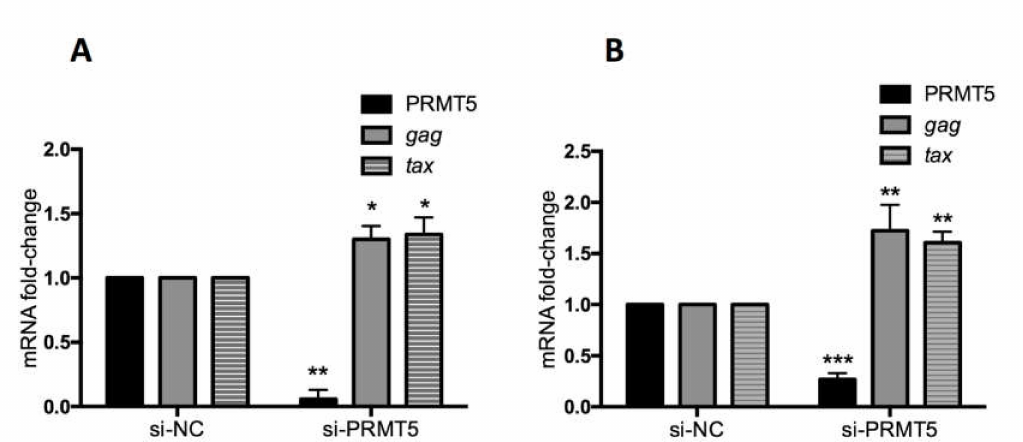
Figure 4. E ff ect of PRMT5 knockdown on BLV gene transcription. FLK-BLV ( A ) or PK15-BLV ( B ) cells were transfected with scramble siRNA (si-NC) or siRNA targeting PRMT5 (si-PRMT5) for 48 h for FLK-BLV or 72 h for PK15-BLV. BLV gene transcription (mRNA- gag and mRNA- tax ) in addition to PRMT5 gene expression at the RNA level was evaluated by qRT-PCR. The ∆∆ CT method was used to calculate the fold-change and GAPDH expression was used as an internal control. Error bars represent the standard deviation of three experiments. The p value was calculated using the Student’s t -test. The asterisk indicates a significant di ff erence (* p ≤ 0.05, ** p ≤ 0.01, and *** p ≤